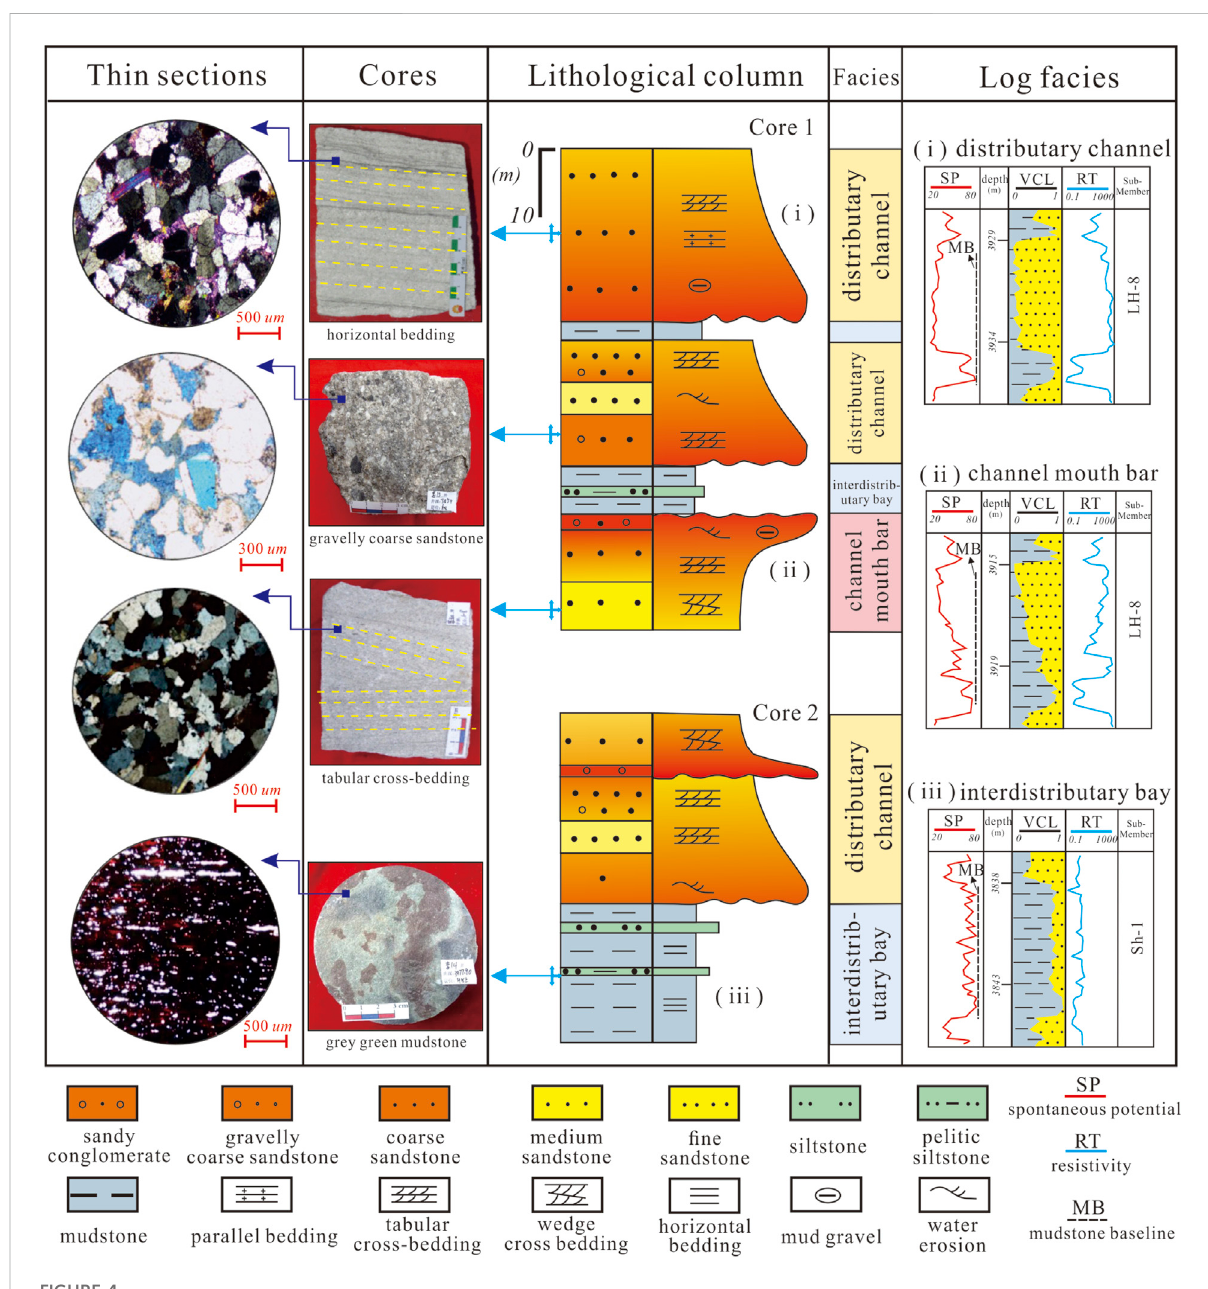
FIGURE 4 Delta plain and delta front sub-facies markers in the Sh-1 to He-8